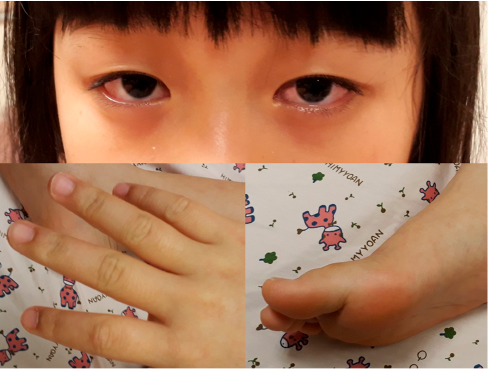
Figure 1. Bilateral bulbar non-exudative conjunctival injection, swelling, and erythematous change of fingers and soles.